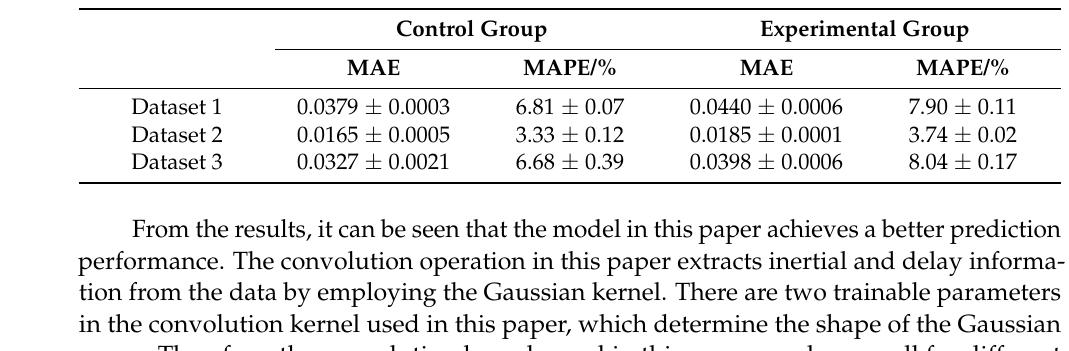
Figure 13. The prediction comparison diagram of Gaussian convolution kernel. Table 8. The prediction comparison table of differential processing of input